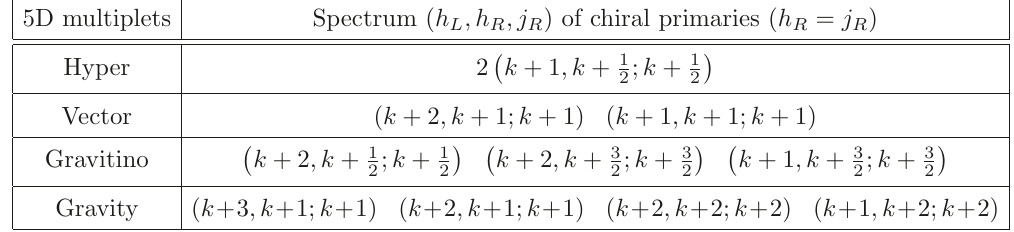
2 . The label k = 0 , 1 , . . . . 3 × S × M S 2 for theories on AdS 2 S 2 × ×